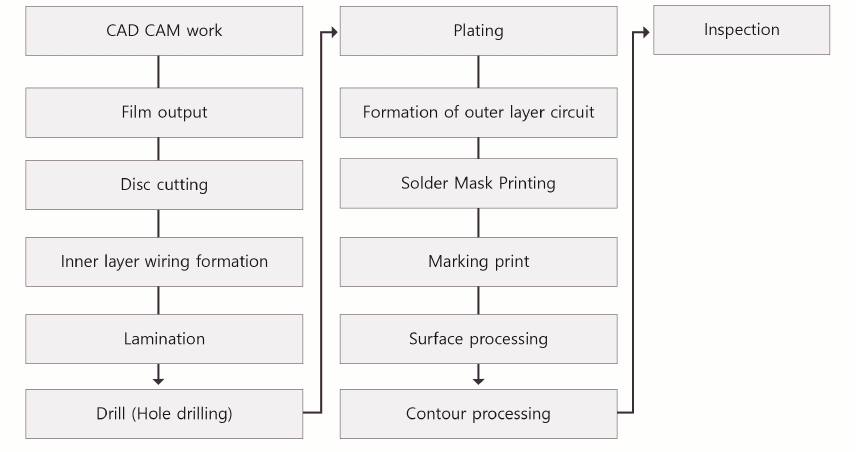
Figure 1. The general PCB manufacturing